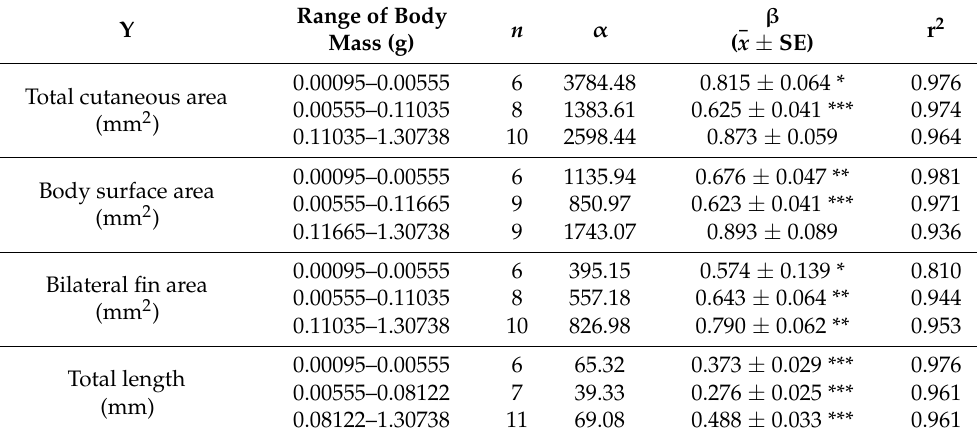
Table 2. Regression analyses of the allometric relationships (Y = α M β ) between body mass (M) and body surface area, fin area, total cutaneous area, and total length (Y).